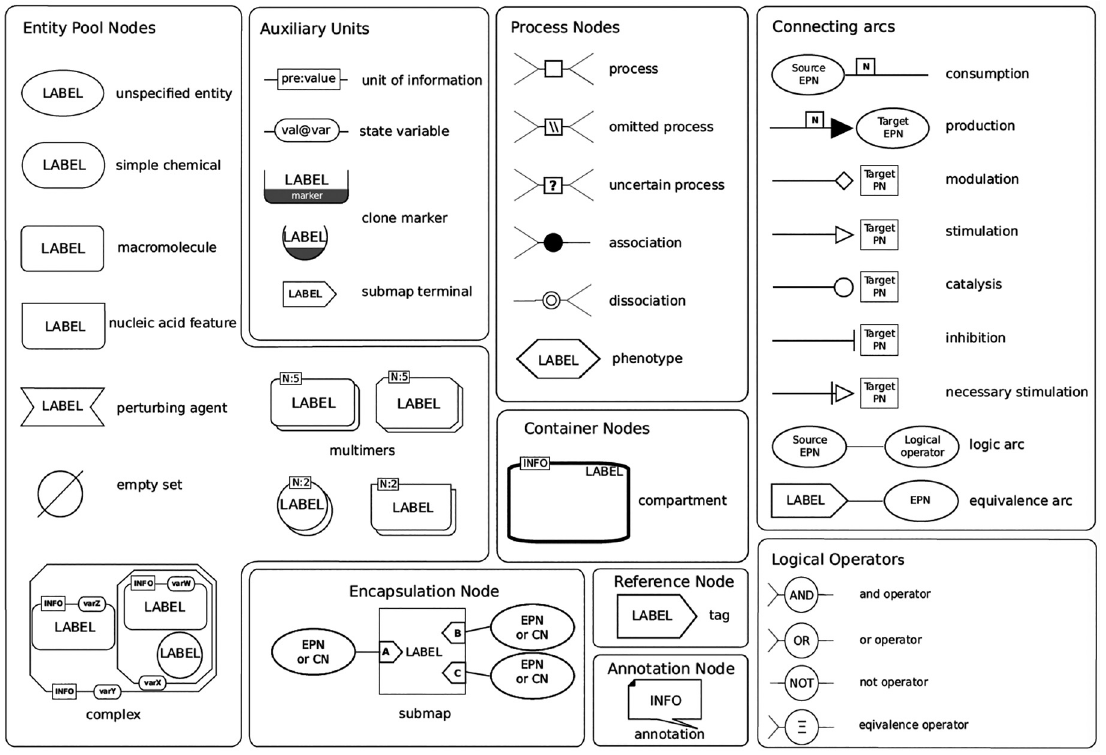
Figure 5: SBGN PD reference card showing all PD glyphs (from